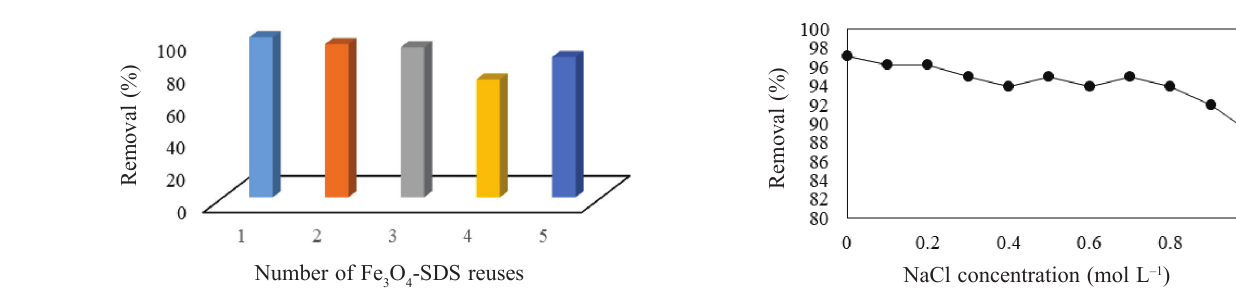
Fig. 8 – Removal efficiency of TC during five repeated usag- es of Fe O -SDS. Test conditions: pH = 6; 100 ml Tc solution 3 4 (2 mg L –1 ); 0.6 g Fe O -SDS; 30 °c temperature, and 3 min 3 4 stirring time (100 rpm).